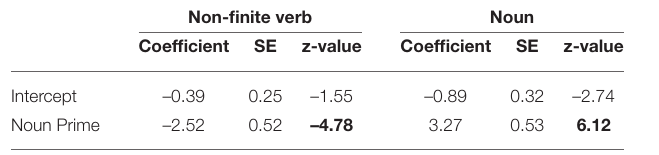
TABLE 2 | Glmer results for the non-finite verb and noun completions in the two conditions for Experiment 1. The analysis uses treatment contrast, with the Non-finite Prime condition as the baseline with the coefficient signifying the difference from the